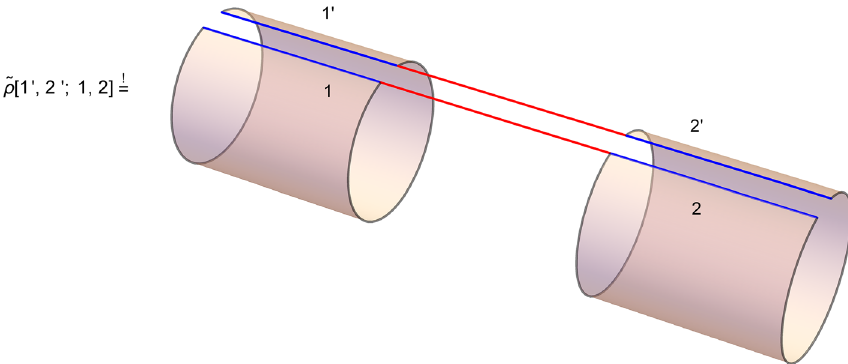
Fig. 15 Complex extension of the segments (cid:2) − and (cid:2) + , and geometric representation of the reduced density matrix. Here the reduced density matrix has not been fully specified yet. To fully specify it, we must fill in the geometry in between the two